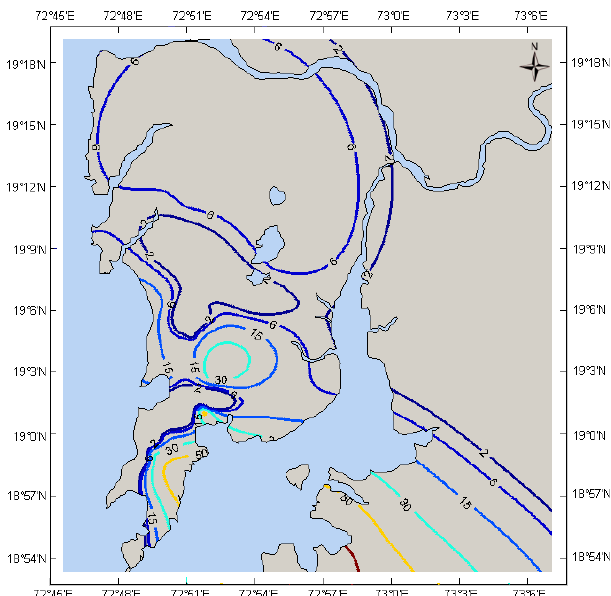
Fig. 7. Contour map of liquefaction potential index (LPI) for earth- quake of magnitude M w = 6.5 of 2475-yr return period.